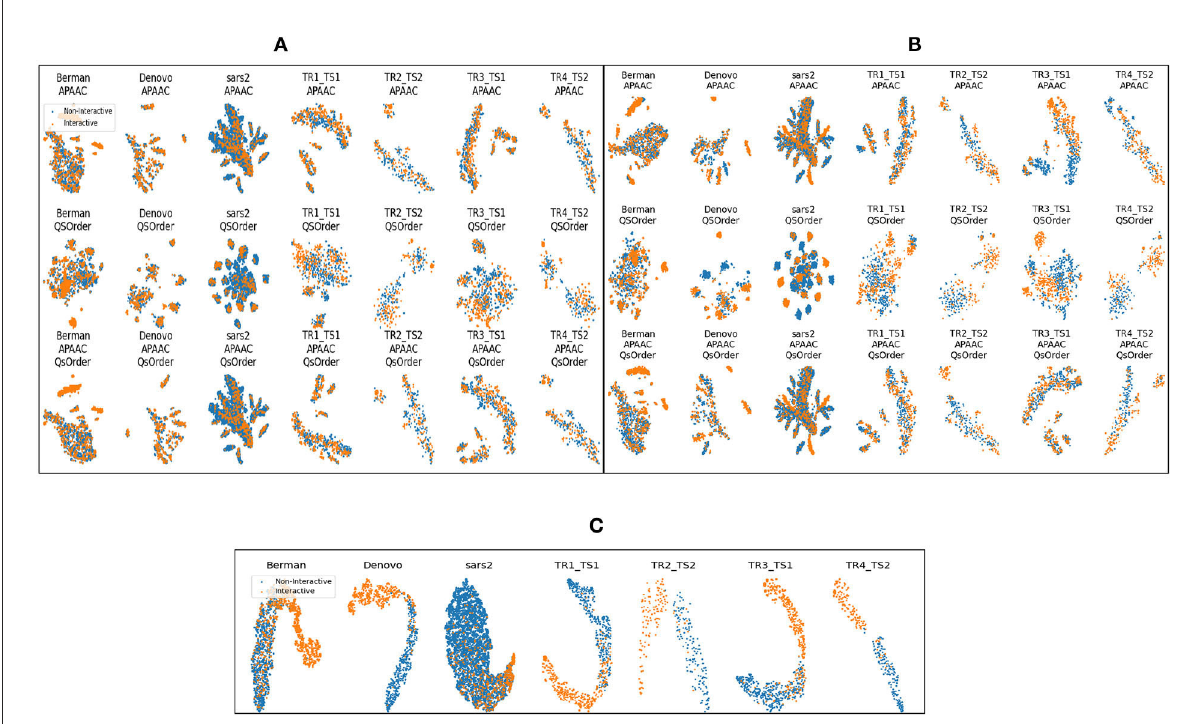
FIGURE4 Formation of clusters with representations of protein sequences based on (A) APAAC and Qsorder encoders without dimensionality reduction (B) APAAC and Qsorder encoders with dimensionality reduction (C) the positive class probabilities through ET and RF classifiers.